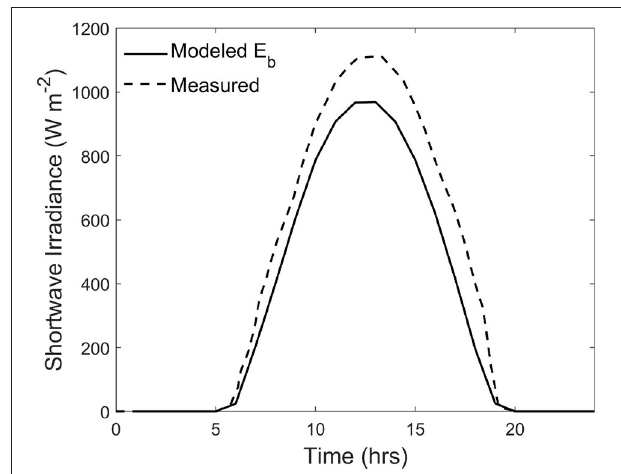
FIGURE 1 | Simulated short-wave direct-beam irradiance ( E b ) component (wavelength range: 0.3 µ m to 3 µ m) for the Baltoro Glacier, compared to field measurements of short-wave irradiance at the same location on July 24th 2004. The discrepancy in magnitude is mainly caused by the diffuse-skylight irradiance and the adjacent-terrain